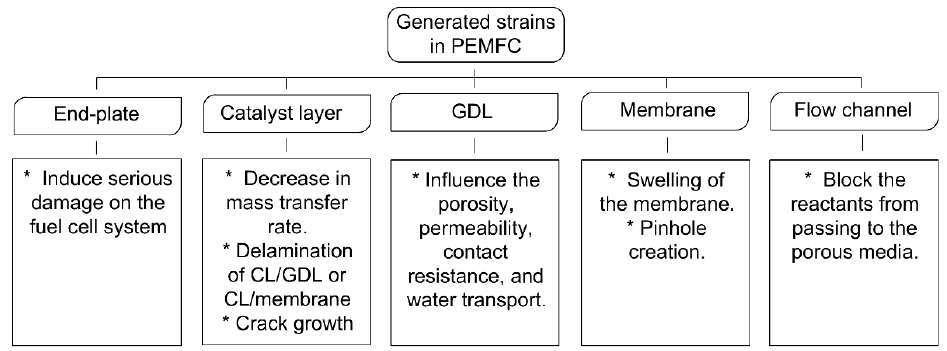
Figure 11. The effects of deformations in any layer of the PEMFC. Proper sealing is one of the methods to prevent the adverse effects of deformations caused by strains in the system. The failure of seals and gaskets can result in the failure of the whole system, reducing efficiency, and safety concerns. Many investigations have